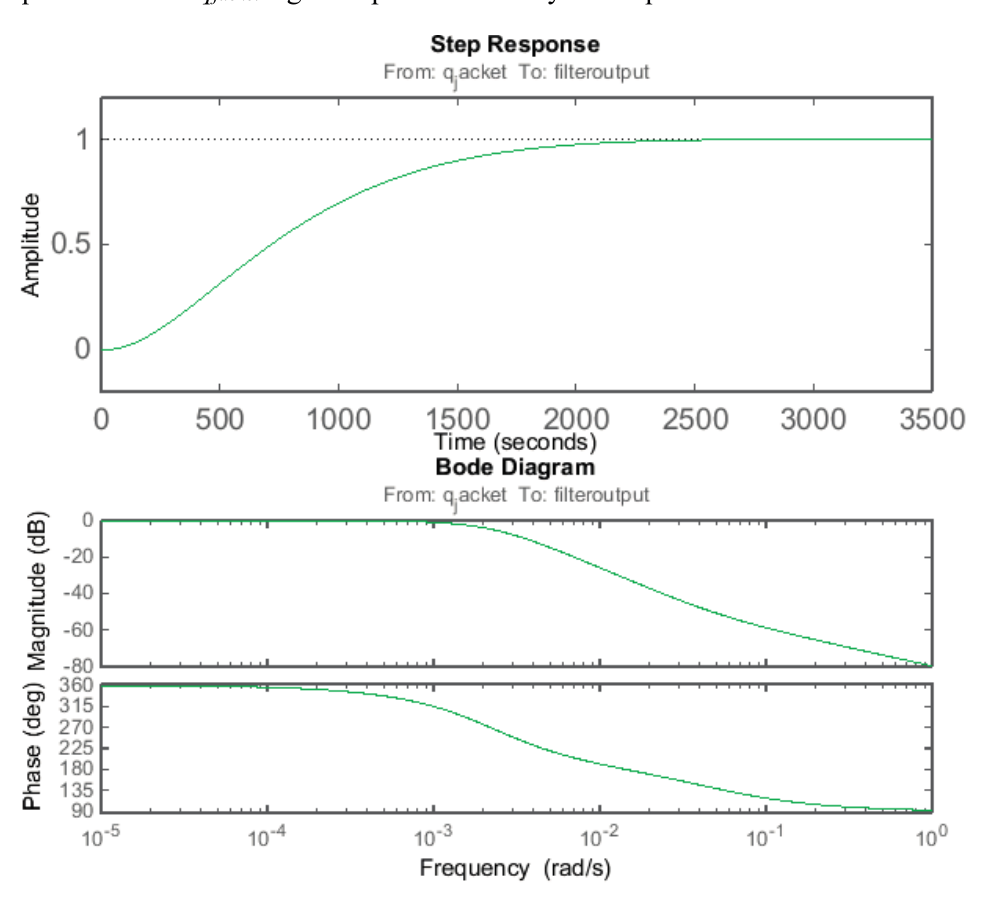
Figure 7. Characterization of the sequential filter based on the model in (Equation (12)). The upper diagram shows a step response of the sequential filter with amplitude of the filter output on the y-axis, expressed as portion of maximum filter output amplitude. The lower diagram shows Bode plots of the filter. Upper panel shows how the magnitude (dB) of the q jacket signal is attenuated for the different noise frequencies that form the signal. Lower panel shows how the frequencies of the q jacket signal is phase shifted by the sequential